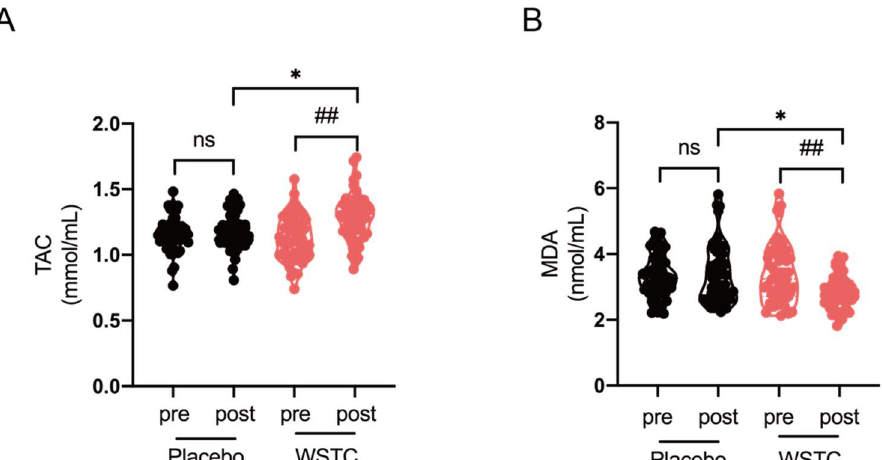
Figure 2. Effects of WSTC supplementation on the serum TAC and MDA levels in healthy middle- aged and elderly adults. ( A , B ) Serum TAC and MDA levels. The values are presented as the means ± SEMs. At baseline, there was no significant difference for the TAC and MDA levels between the two groups. * p < 0.05, one-way analysis of variance for independent data is used for comparison between the two groups after 4 weeks of intervention. ## p < 0.01 vs. baseline in the WSTC group, assessed by a paired Student’s t -test. Abbreviations: TAC, total antioxidant capacity, MDA, malonaldehyde, WSTC, water-soluble tomato concentrate and ns, no significance.